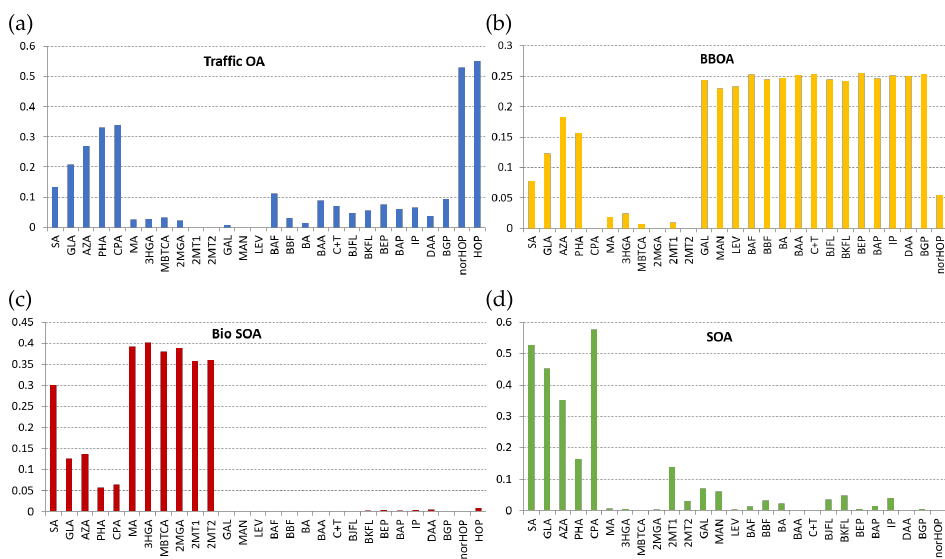
Figure 6. Loadings of the organic tracer compounds in the ( a ) Traffic OA; ( b ) BBOA; ( c ) Bio SOA; ( d ) SOA components, obtained after MCR-ALS